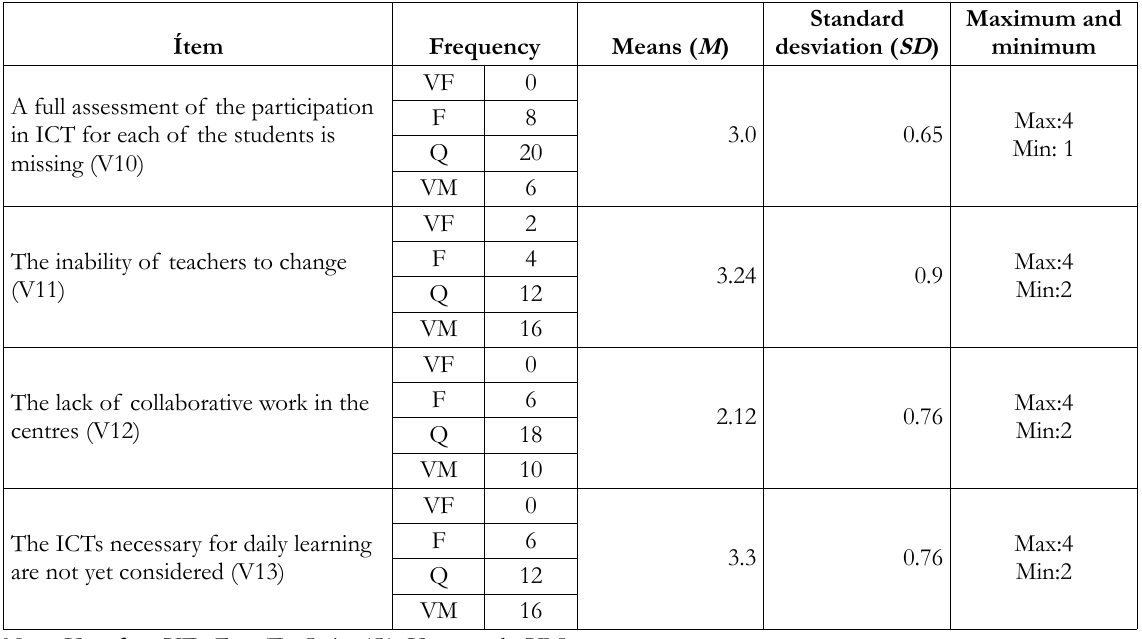
Table 6. Values of the dimensions linked to the barriers that ICTs have in